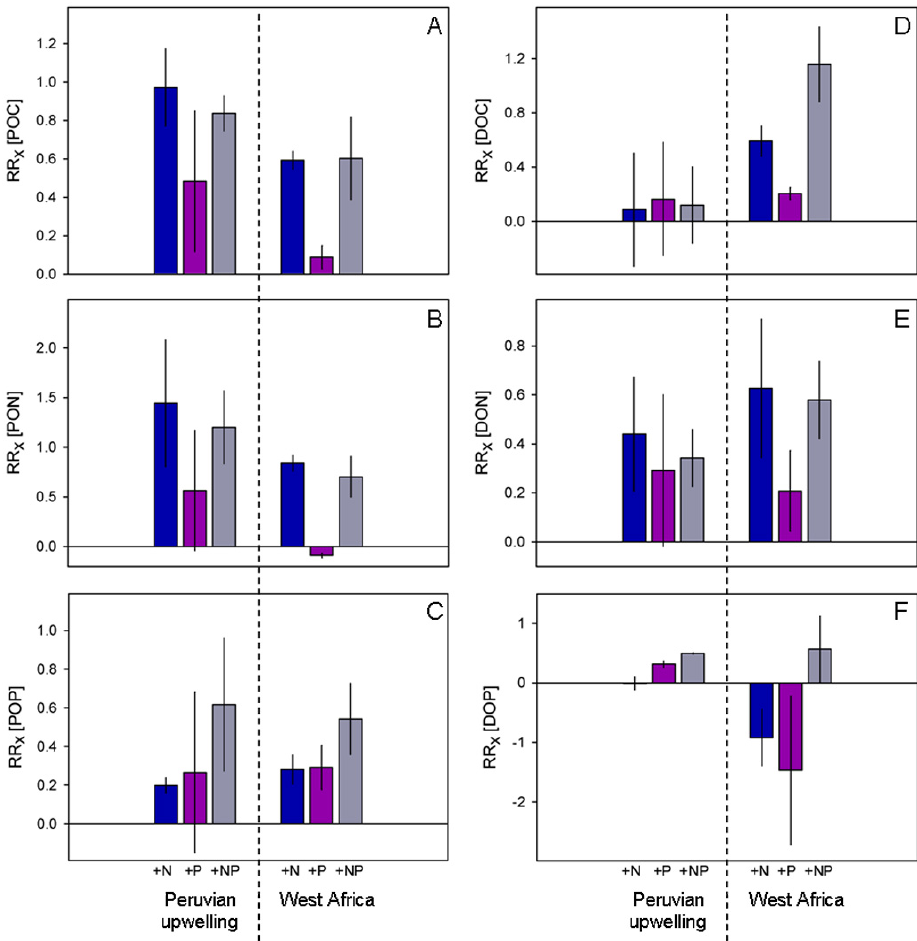
Fig. 4. Relative responses (RR x ) of the microbial communities to enrichment in high N ( + N, blue), high P ( + P, purple) or to combined high N and high P ( + NP, grey), during the PU (Peruvian upwelling) and the WA (West Africa) experiments. Response variables are build-up of (A) POC, (B) PON, (C) POP, (D) DOC and (E) DON. (F) Since no accumulation of DOP could be determined for the WA experiment, absolute concentrations of DOP were used to evaluate RR x . For detailed calculation of RR x , see Sect. 2.8. Values are treatment means and the error bars denote the standard deviation for two consecutive days of production within each treatment of high nutrient